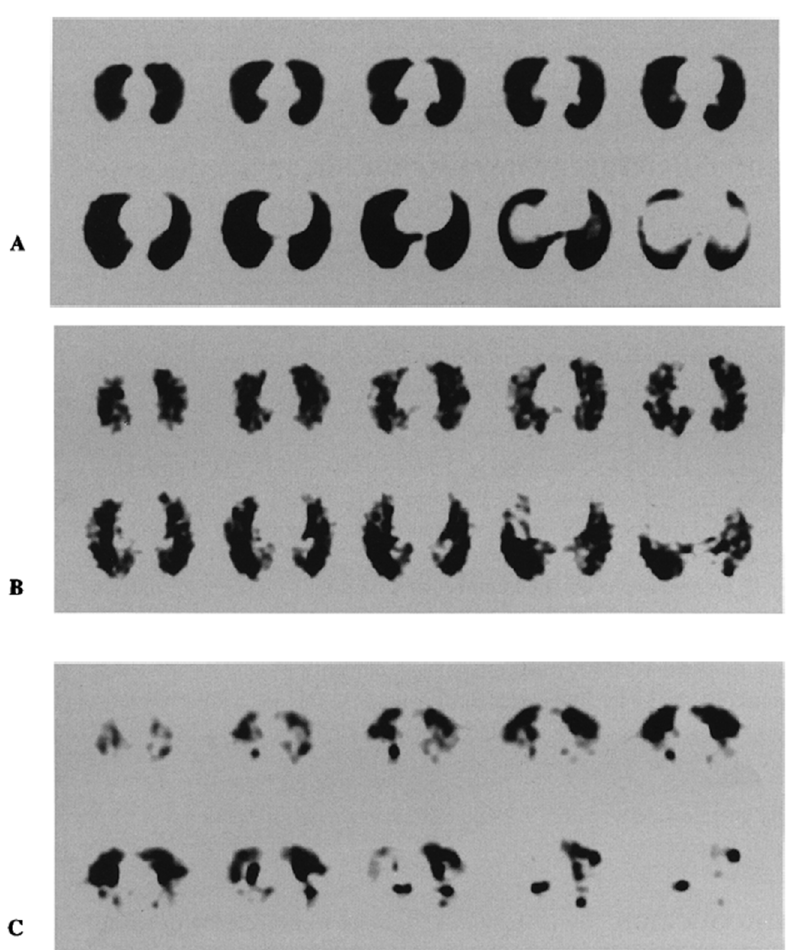
Figure 12. ( A ) A 45-year-old healthy male. Technegas SPECT images show homogeneous distribution in whole lung. ( B ) A 65-year-old male with mild emphysema. Technegas SPECT images show heterogeneous distribution in whole lung. ( C ) A 63-year-old male with severe emphysema. Technegas SPECT images show heterogeneous distribution of cold and hot spots throughout peripheral lung field. Reprinted/adapted with permission from Ref. [36]. 2002, Springer Nature.